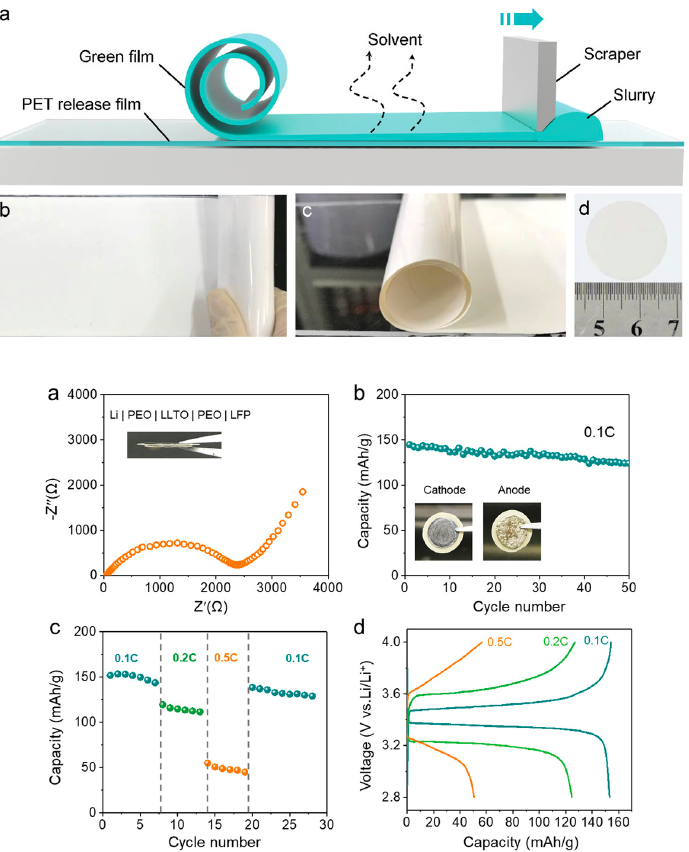
Figure 13. Schematic images of ( a – d ) tape-casting method and battery performance of Li|LFP cell. Reprinted from [107], Copyright (2019) John Wiley and Sons, Inc.